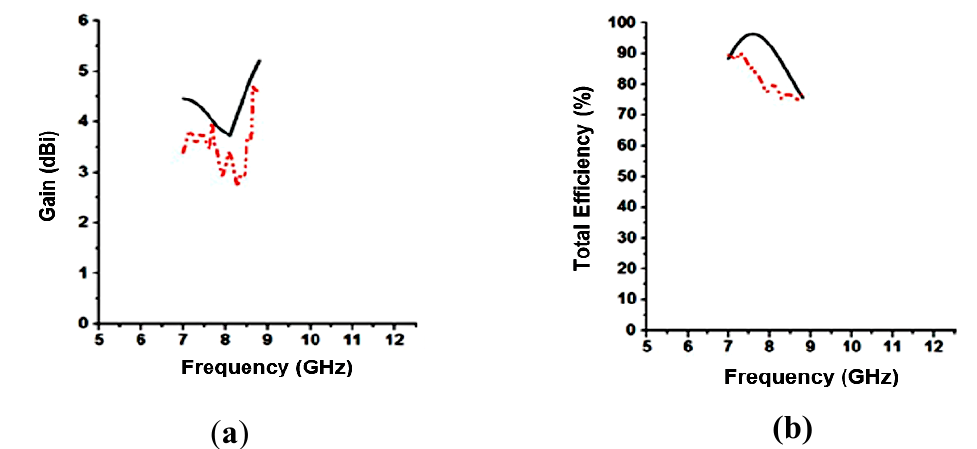
Figure 5. Measured and simulated, ( a ) gain and ( b ) total efficiency of the designed flexible antenna; at 42% concentration of nickel.